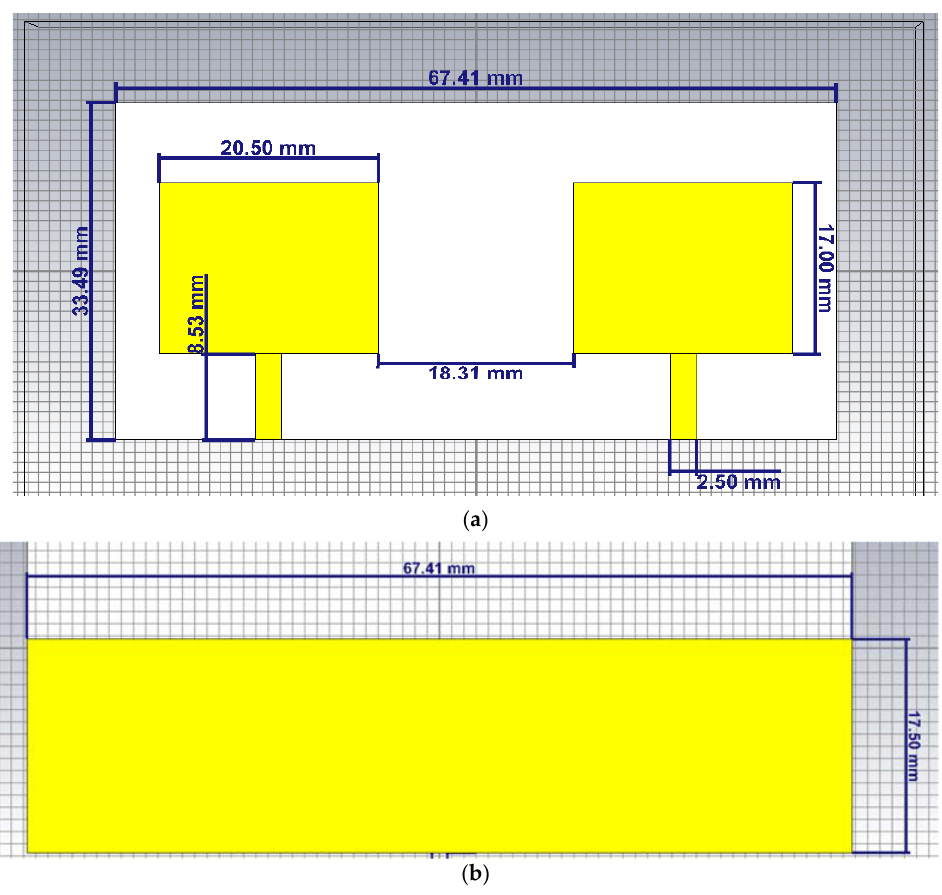
Figure 1. Structure of 2 × 1 microstrip patch array of antenna without decoupling slab ( a ) front view ( b ) back view. It was found that the current density distributed over the antenna array surface is higher without DS. Figure 2 shows high surface current density.